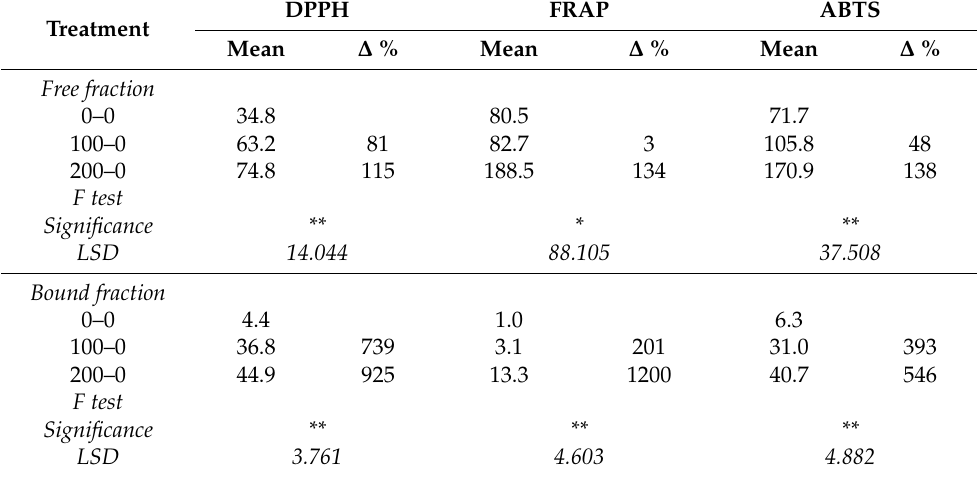
Table 6. Antioxidant activity measured by DPPH, FRAP and ABTS tests ( µ mol Trolox equivalents g − 1 DW) of the free, bound fractions of extracts in the rapeseed sprouts obtained from seeds harvested from mother plants grown under the three salinity treatments S0, S100 and S200 (i.e., 0, 100 and 200 mM of NaCl in the solution used for watering the pots throughout the whole growing